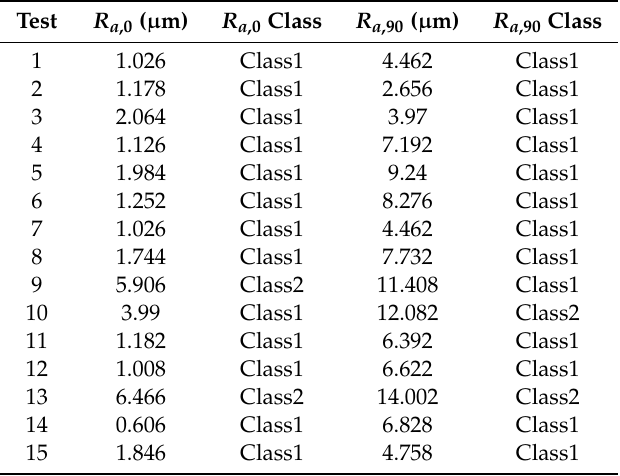
Figure 4. J48 (C4.5) decision tree for R a ,90 . Table 5. Testing dataset: results for surface roughness ( R a ,0 , R a ,90 ).